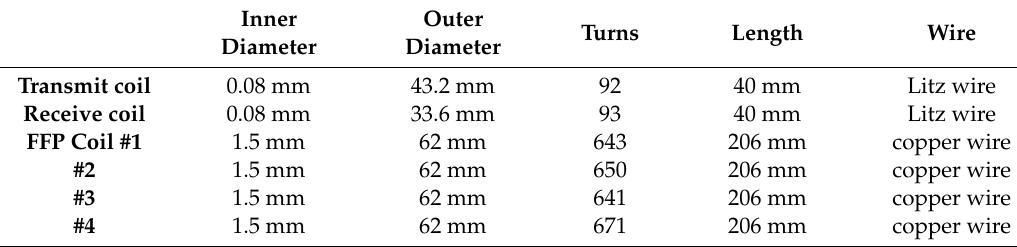
Table 2. Detailed parameters of the proposed coil